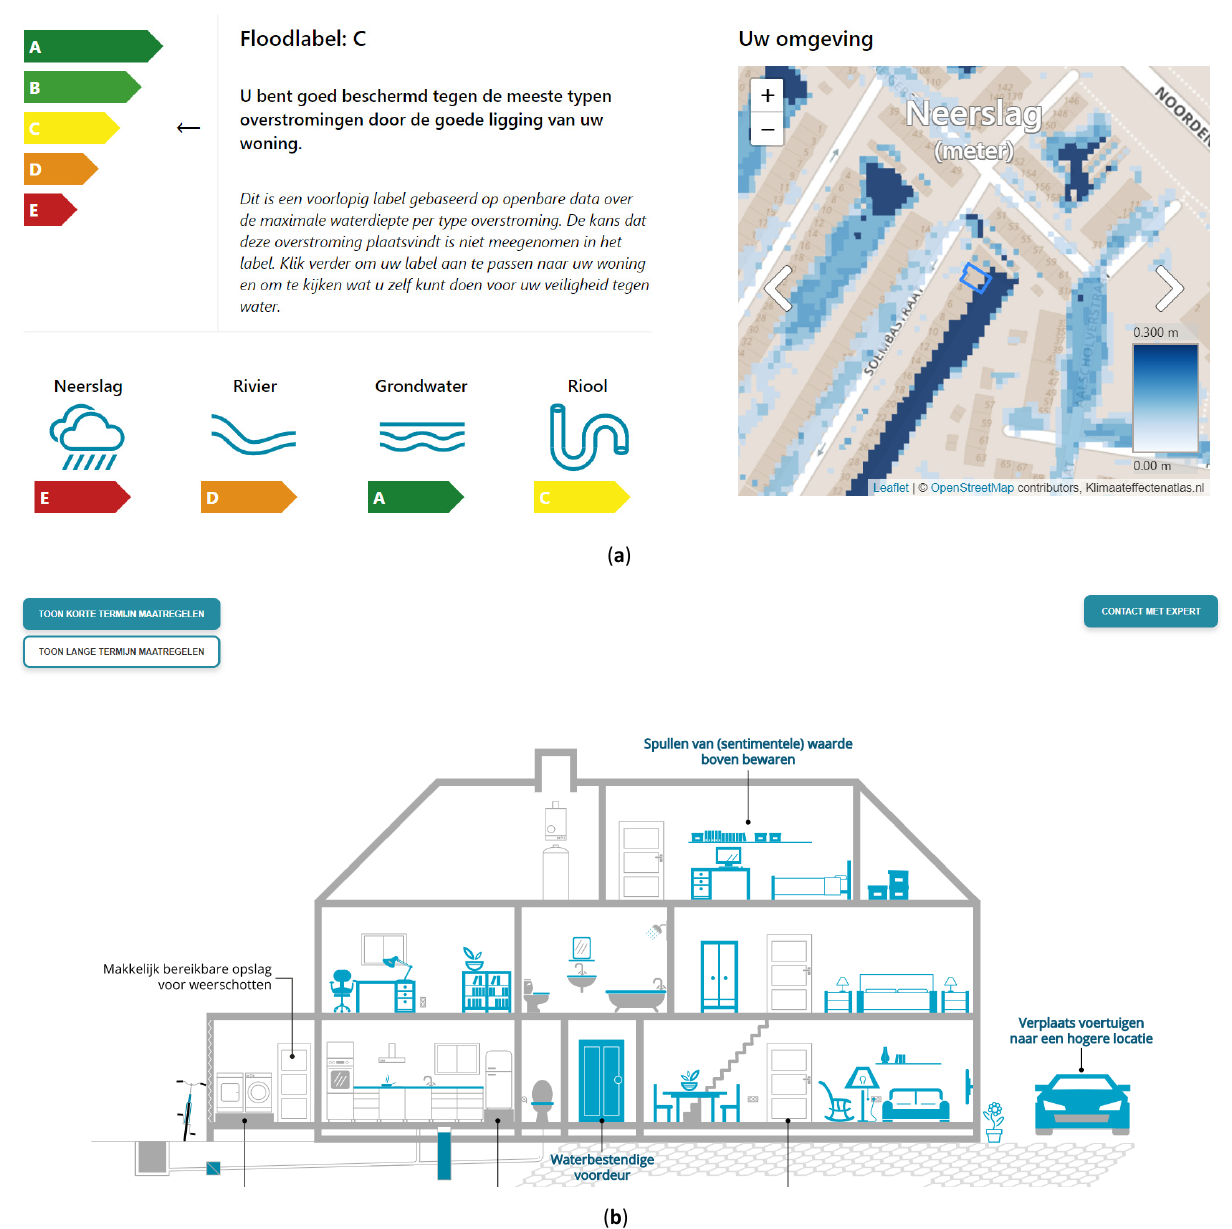
Figure 2. Screenshots from the FLOODLABEL application. ( a ) The left panel presents the flood label for different types of flooding (see symbols). The right panel shows the precipitation at the parcel level, but the user can also switch to the fluvial flooding or groundwater level maps. ( b ) The tool displays two figures for both short‐term and long‐term measures to implement in and around the house. On the website, below the figures, detailed information on each of the suggested measures is given. Source: FLOODLABEL